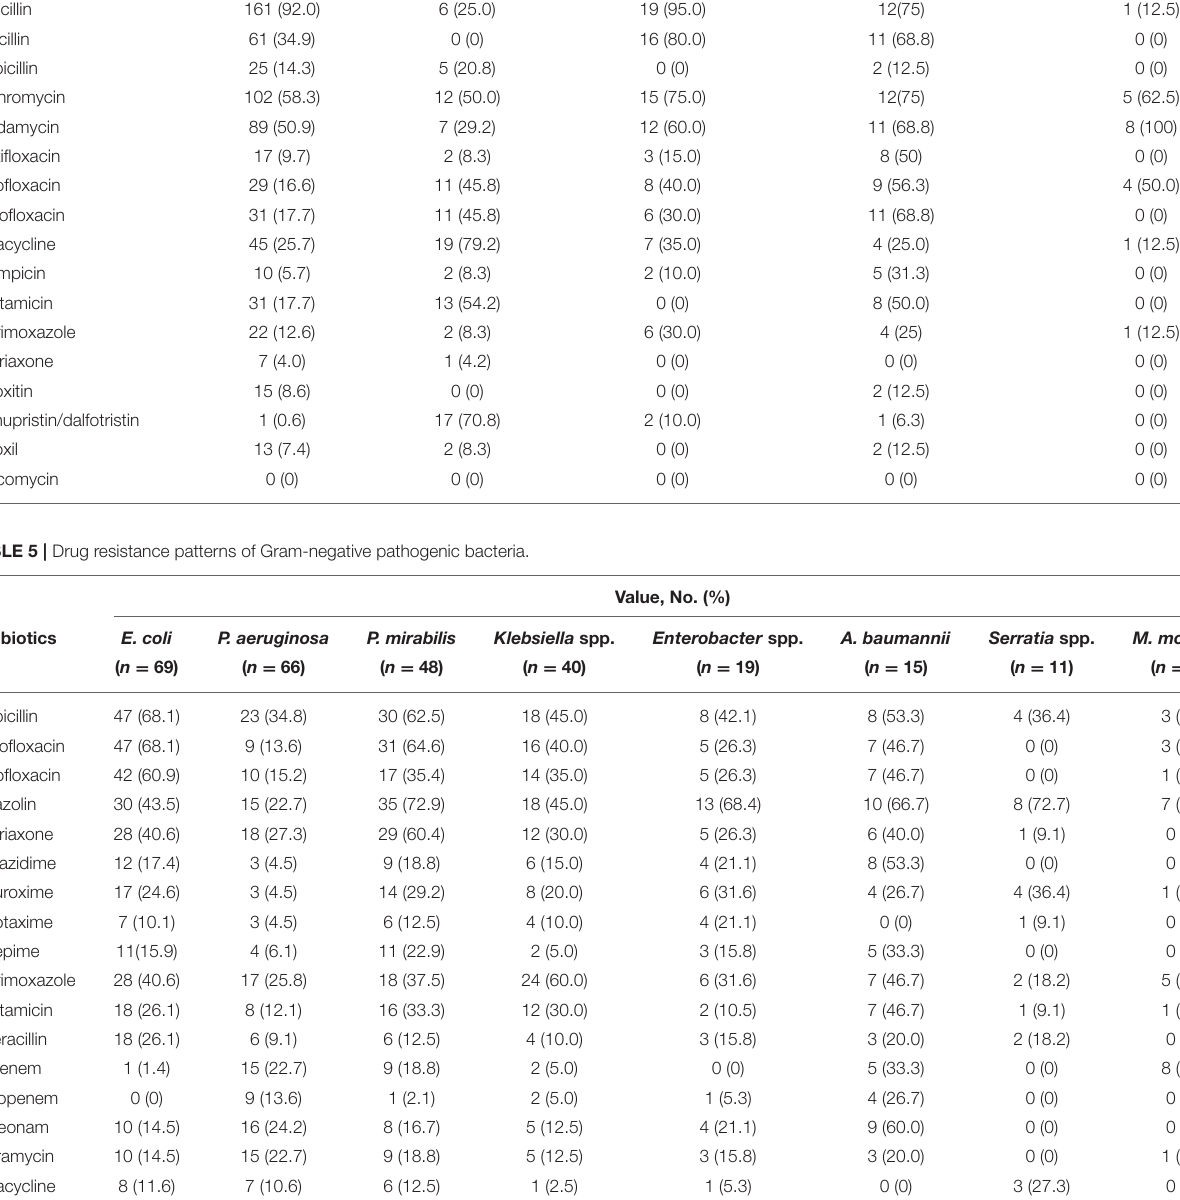
TABLE 4 | Drug resistance patterns of Gram-positive pathogenic bacteria. Antibiotics